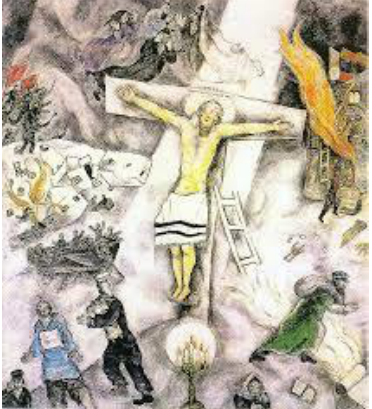
Fig. 12 The white crucifixion, Chagall